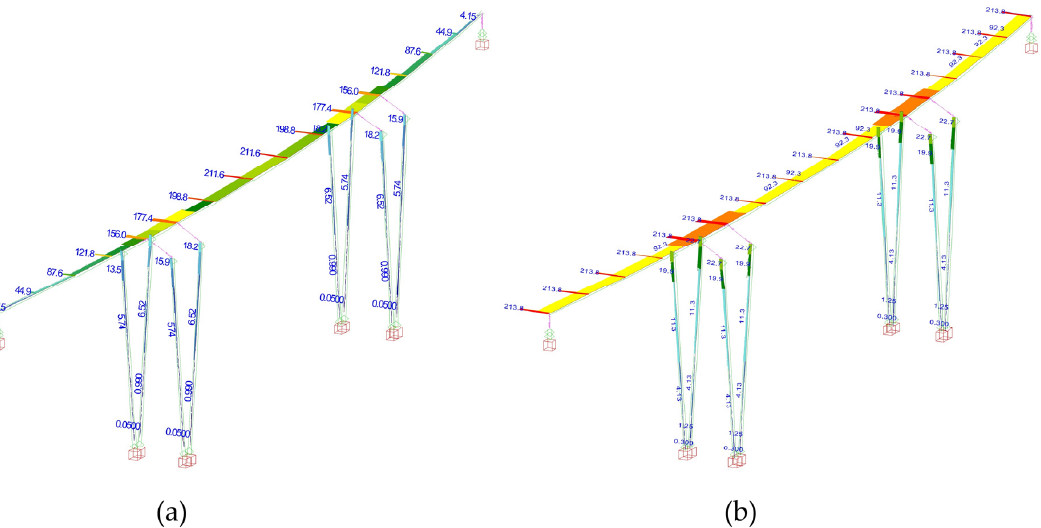
Figure 9. ( a ) horizontal load distribution along the superstructure; ( b ) horizontal load in proportion with dominant modal